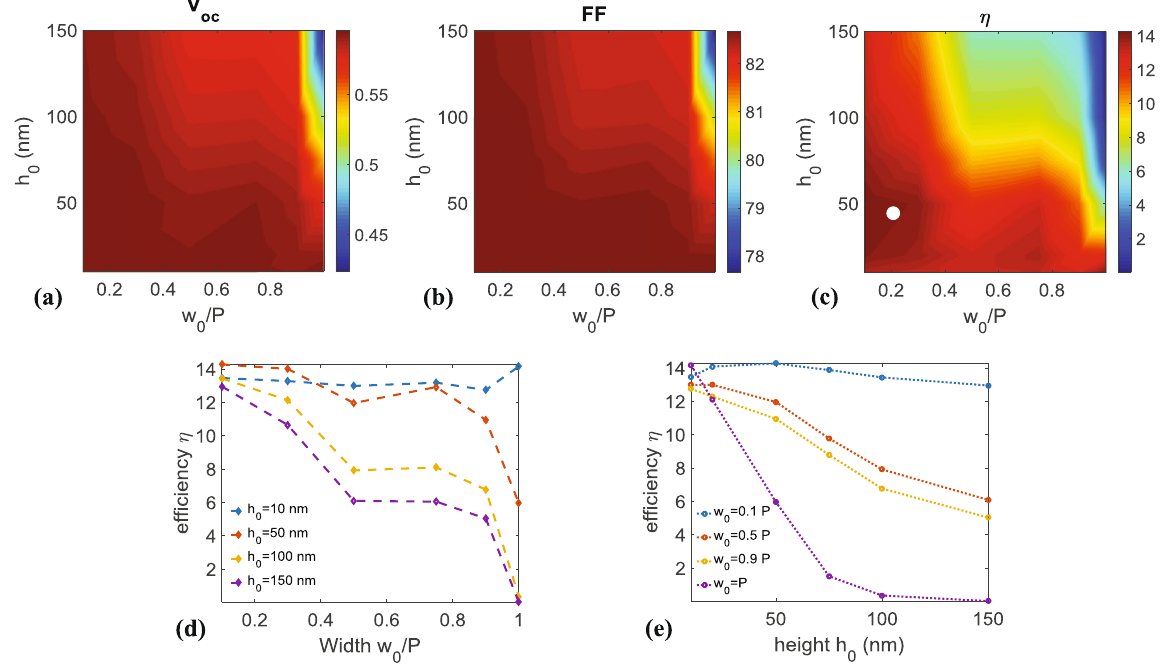
Figure 4. ( a ) Open-circuit voltage ( V ) versus the width and height of the metallic grating. ( b ) Filling factor oc (FF) versus the width and height of the metallic grating. ( c ) Cell efficiency ( η ) versus the width and height of the metallic grating. Efficiency of the cell for different values of the height ( d ) and width ( e ) of the